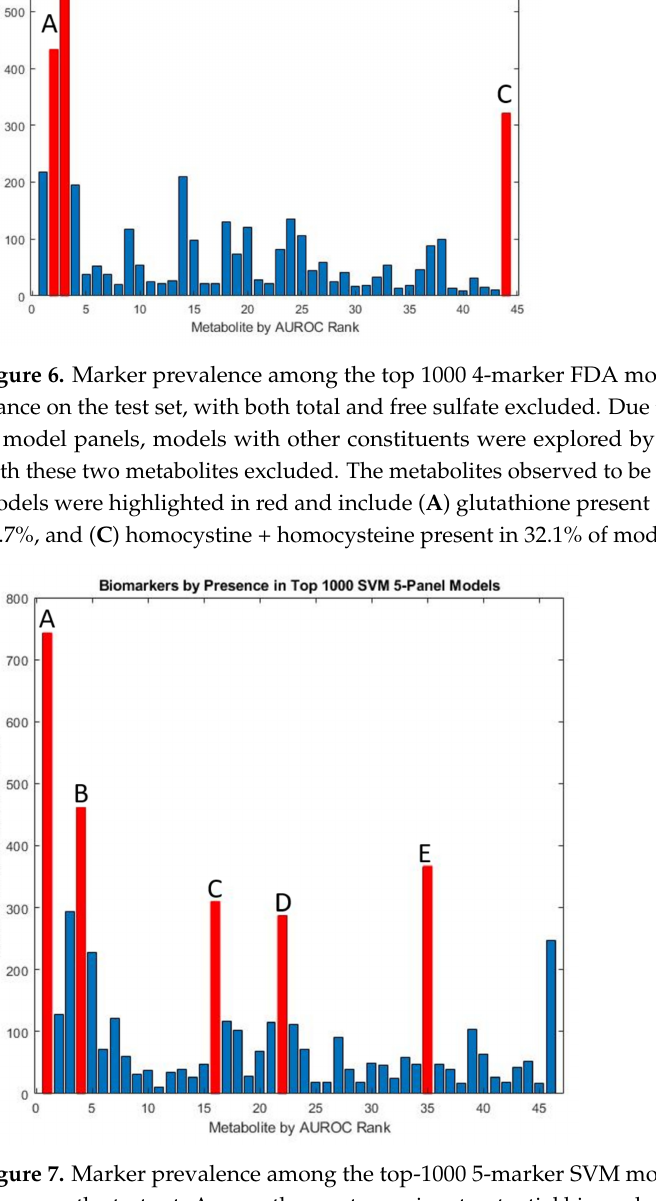
Figure 7. Marker prevalence among the top-1000 5-marker SVM models as judged by their perfor- mance on the test set. Among the most prominent potential biomarkers are ( A ) free sulfate in serum, ( B ) uridine, ( C ) tryptophan, ( D ) beta-amino isobutyrate, and ( E ) copper in whole